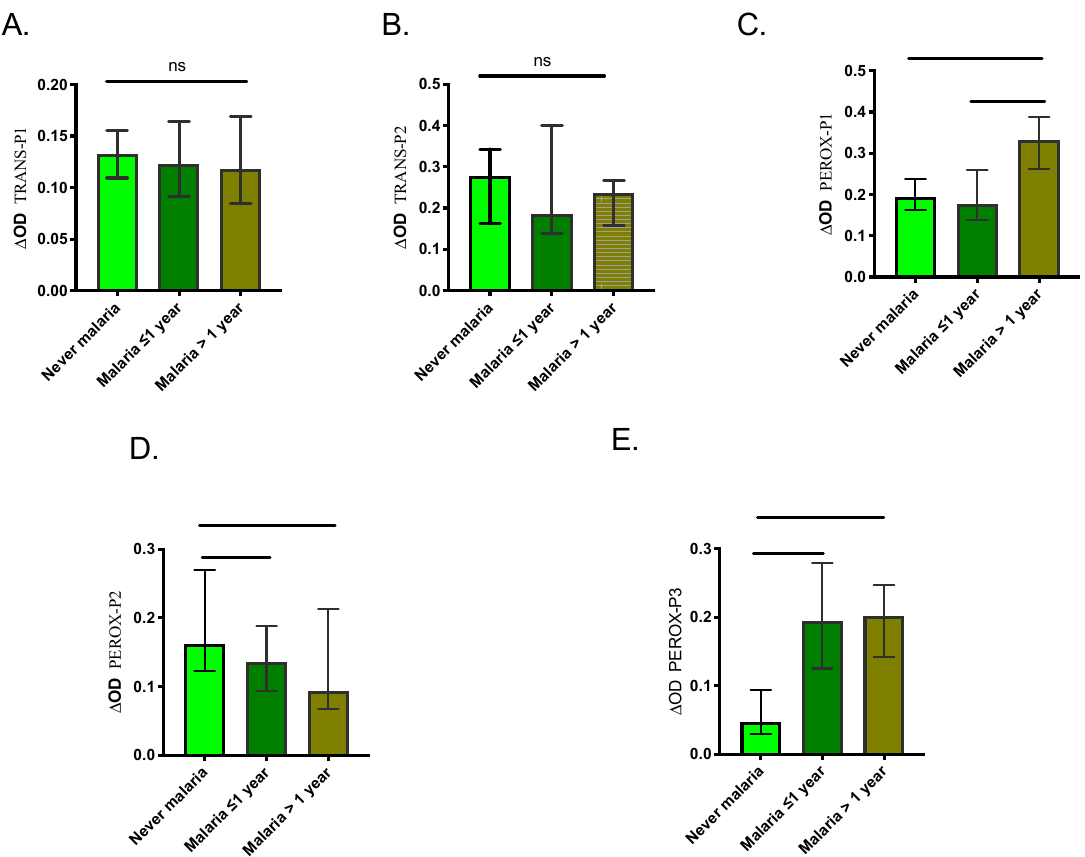
Figure 5. Graphic representation of the IgG antibody levels against each peptide ( A – E ) in samples originating from individuals with a negative malaria diagnosis from each control group. Significance was tested with the Kruskal-Wallis test and Dunn’s multiple comparison test with significance represented by stars ( p < 0.05 (* = 0.0, ** = 0.00 and *** = 0.000). ns denotes “not significant.”